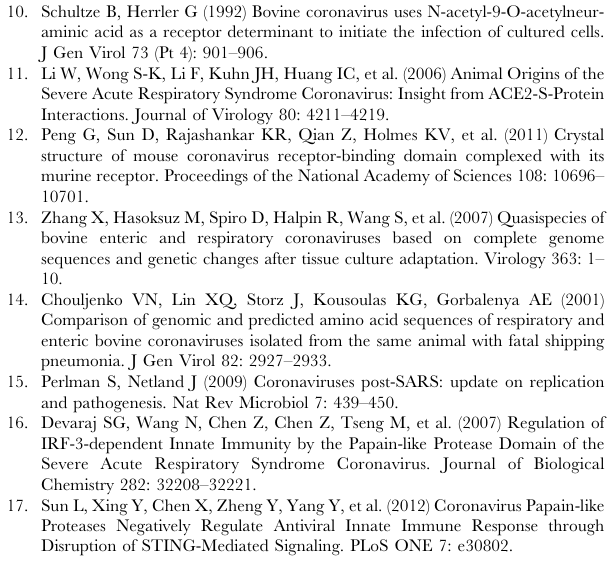
Figure S1 Average coverage per sample (y-axis) versus count of rare variants detected in each sample, with a linear fit. Table S1 Primers used to amplify regions of the BCoV genome. Table S2 Amplification of BCoV RNA from NVSL by Taqman using Polymerase and Insert Primers. Table S3 Summary deep sequencing data. Table S4 Putative genetic markers of cell culture adaptation. Table S5 Comparison of amino acid changes